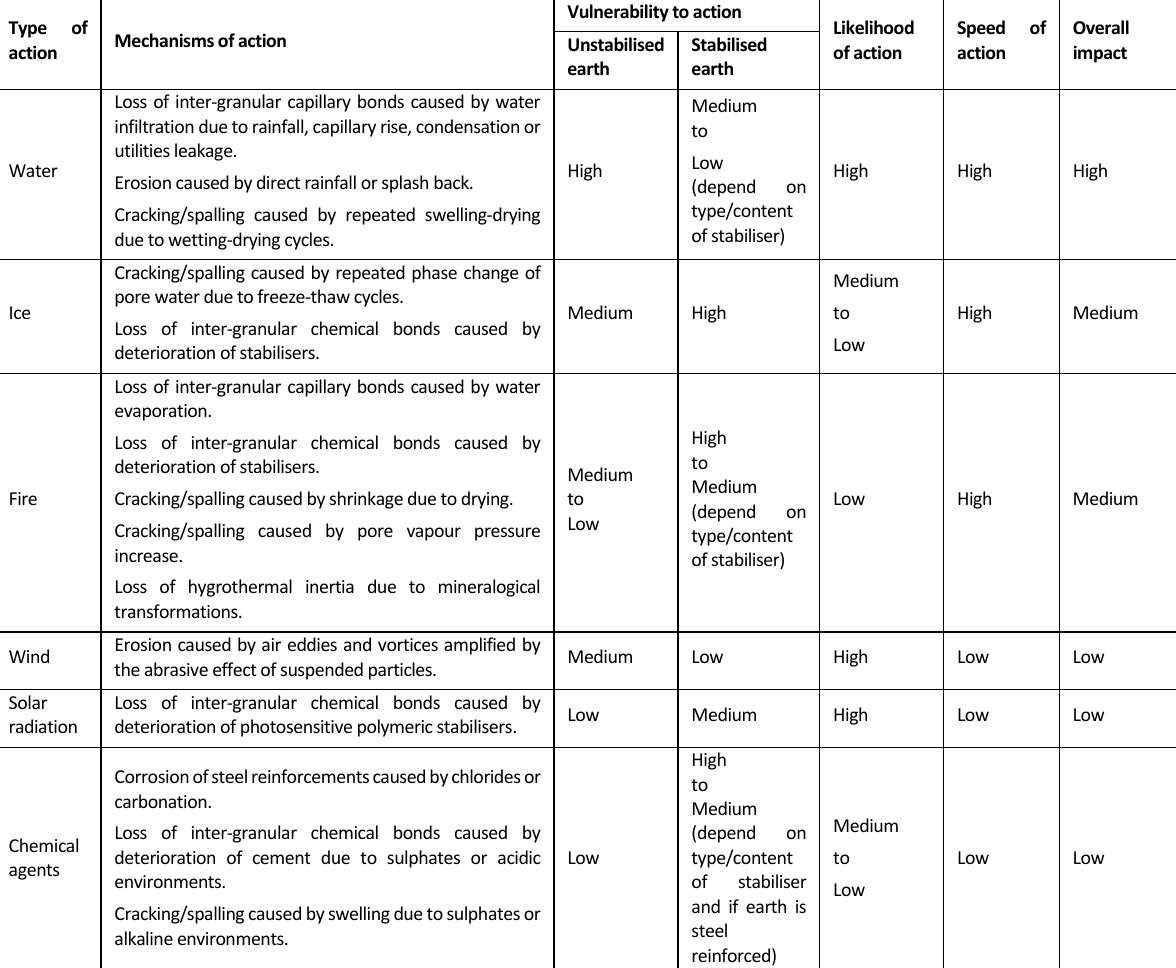
Table 1. Description of main environmental actions affecting the durability of earth buildings.